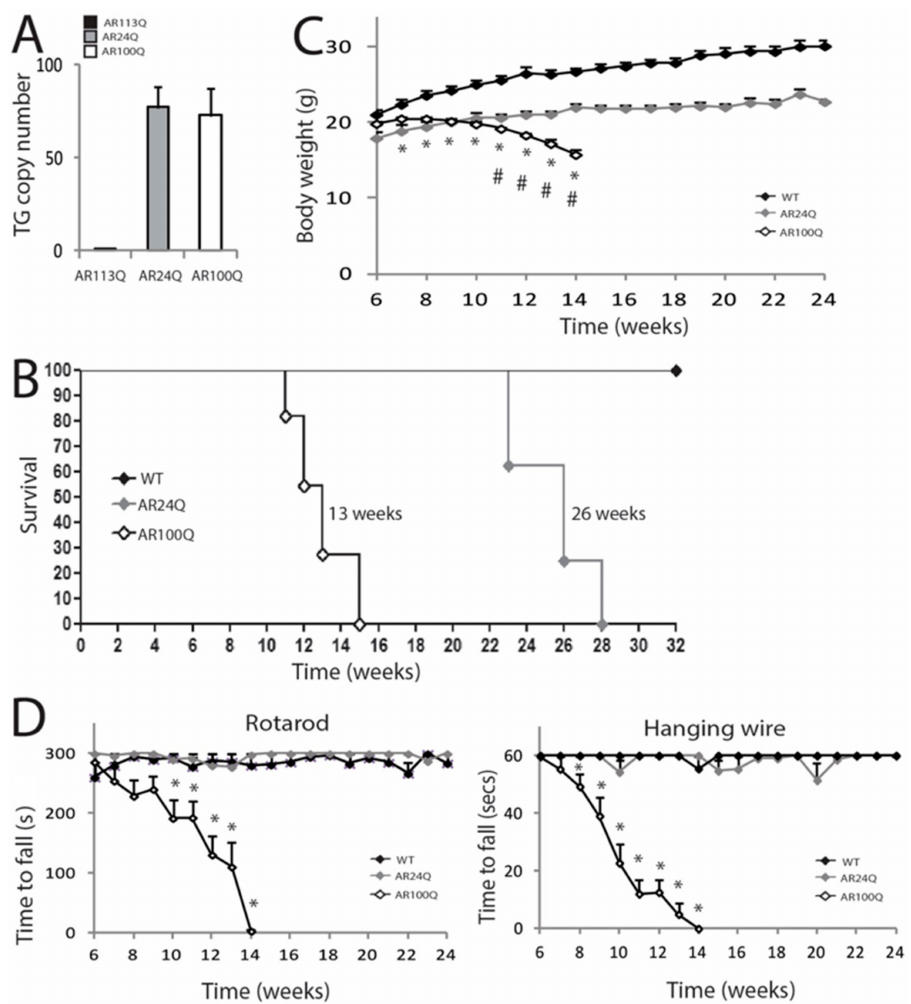
Figure1. AR100Qtransgenicmiceshowreducedlifespanandprogressivemotordysfunction. ( A )Analysis of transgene copy number in knock-in (AR113Q) and transgenic (AR24Q and AR100Q) male mice ( n = 5). ( B ) Kaplan-Meier survival curves of WT ( n = 8), AR24Q ( n = 8) and AR100Q ( n = 11) male mice. Survival curves were compared using Log-rank (Mantel-Cox) test. ( C ) Temporal changes in mean BW of WT ( n = 8), AR24Q ( n = 7) and AR100Q ( n = 14) male mice. ( D ) Temporal changes in mean rotarod and hanging wire task performance in WT ( n = 7), AR24Q ( n = 5) and AR100Q ( n = 12) male mice. Graphs, mean ± SEM. Statistical testing: Mann Whitney test was used to test the difference between genotypes in ( C ) and ( D ). In ( C ) * p < 0.01 for AR100Q vs WT; # p < 0.001 for AR100Q vs AR24Q. In ( D ) * p <